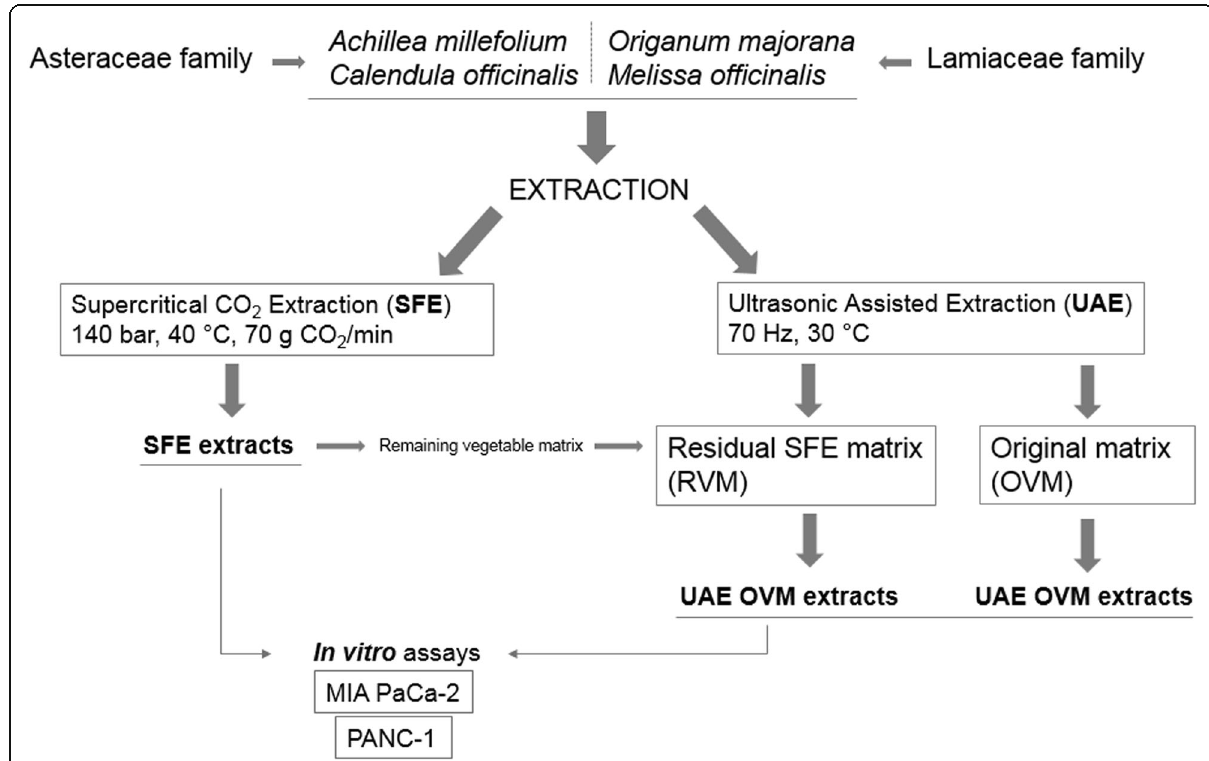
Fig. 1 Screening overview and general approach addressed in the present